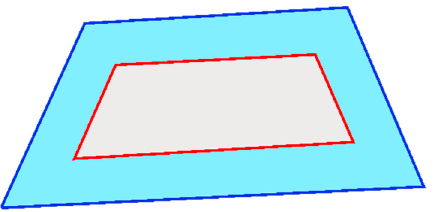
Figure 4. Texture patch with border bars (light blue for outer edge and red for inner edge).